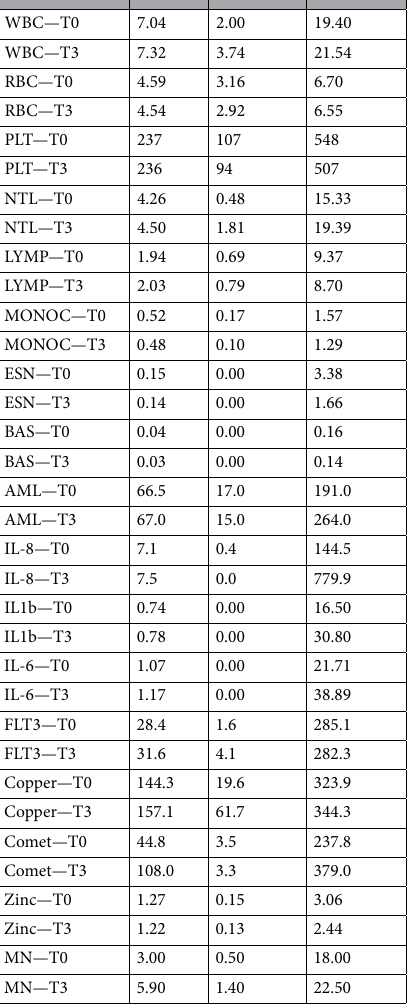
Table 1. Median and range values all the biomarkers included in the study are reported measured pre (T0) and post (T3) the first RT fraction. WBC white blood cells, RBC red blood cells, PTL platelets,